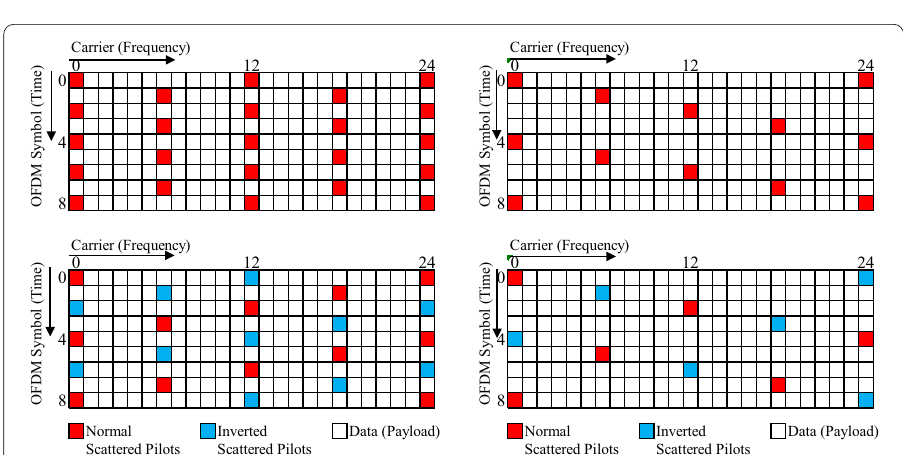
Fig. 5 Scattered pilots used for experiments. Dx MIMO (top for signal #1 and bottom for signal